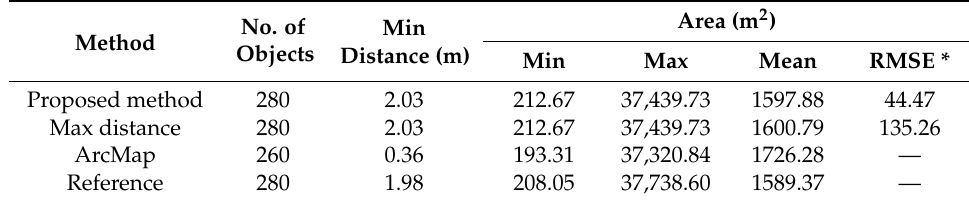
Table 1. Brief summary of generalized objects obtained by the different methods.